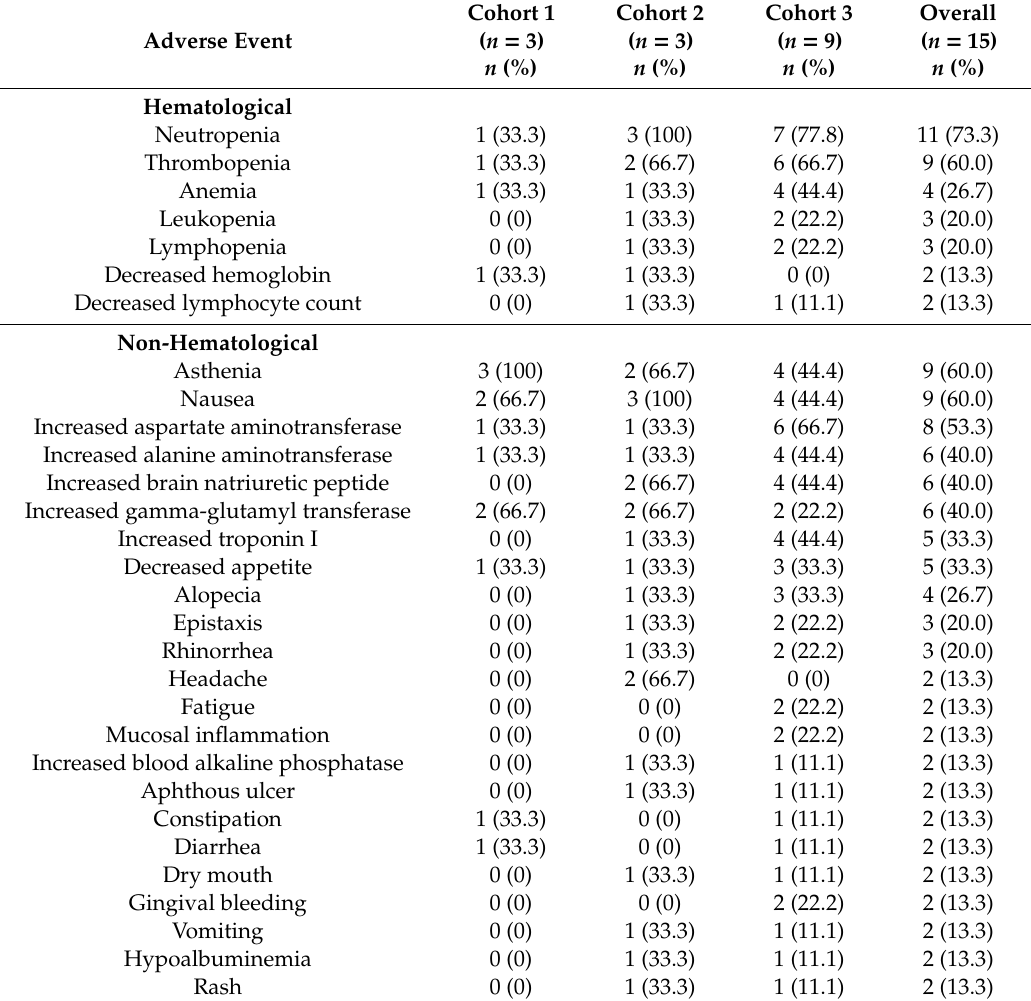
Table 2. Treatment-related adverse events of any grade occurring in more than 10% of